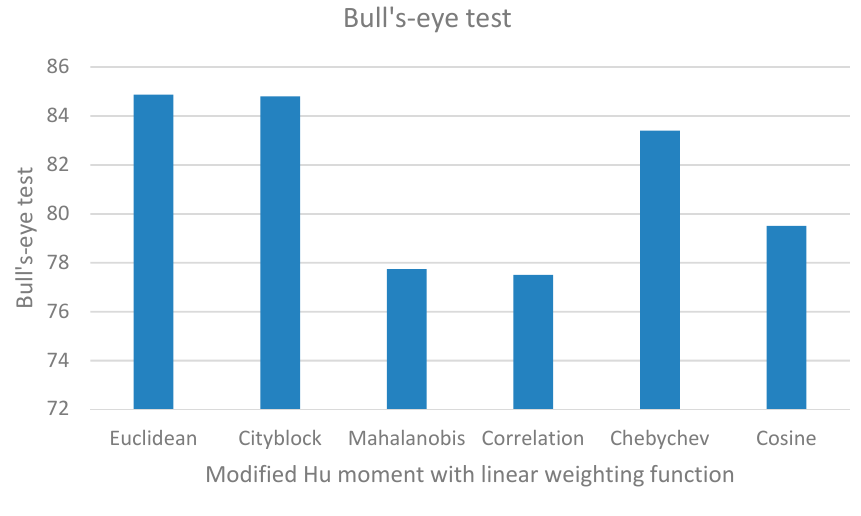
Figure 9. Bull’s-eye test on Kimia’s shape database.